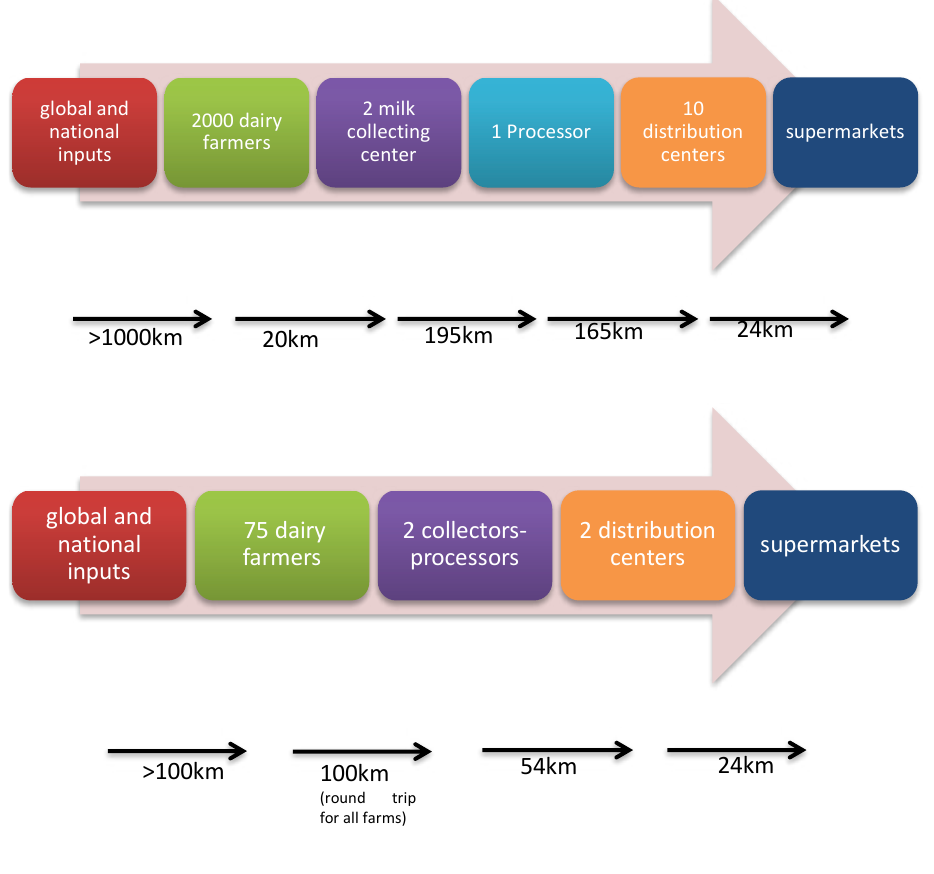
Figure 2. Supply chains of the two milk case studies (global above, local